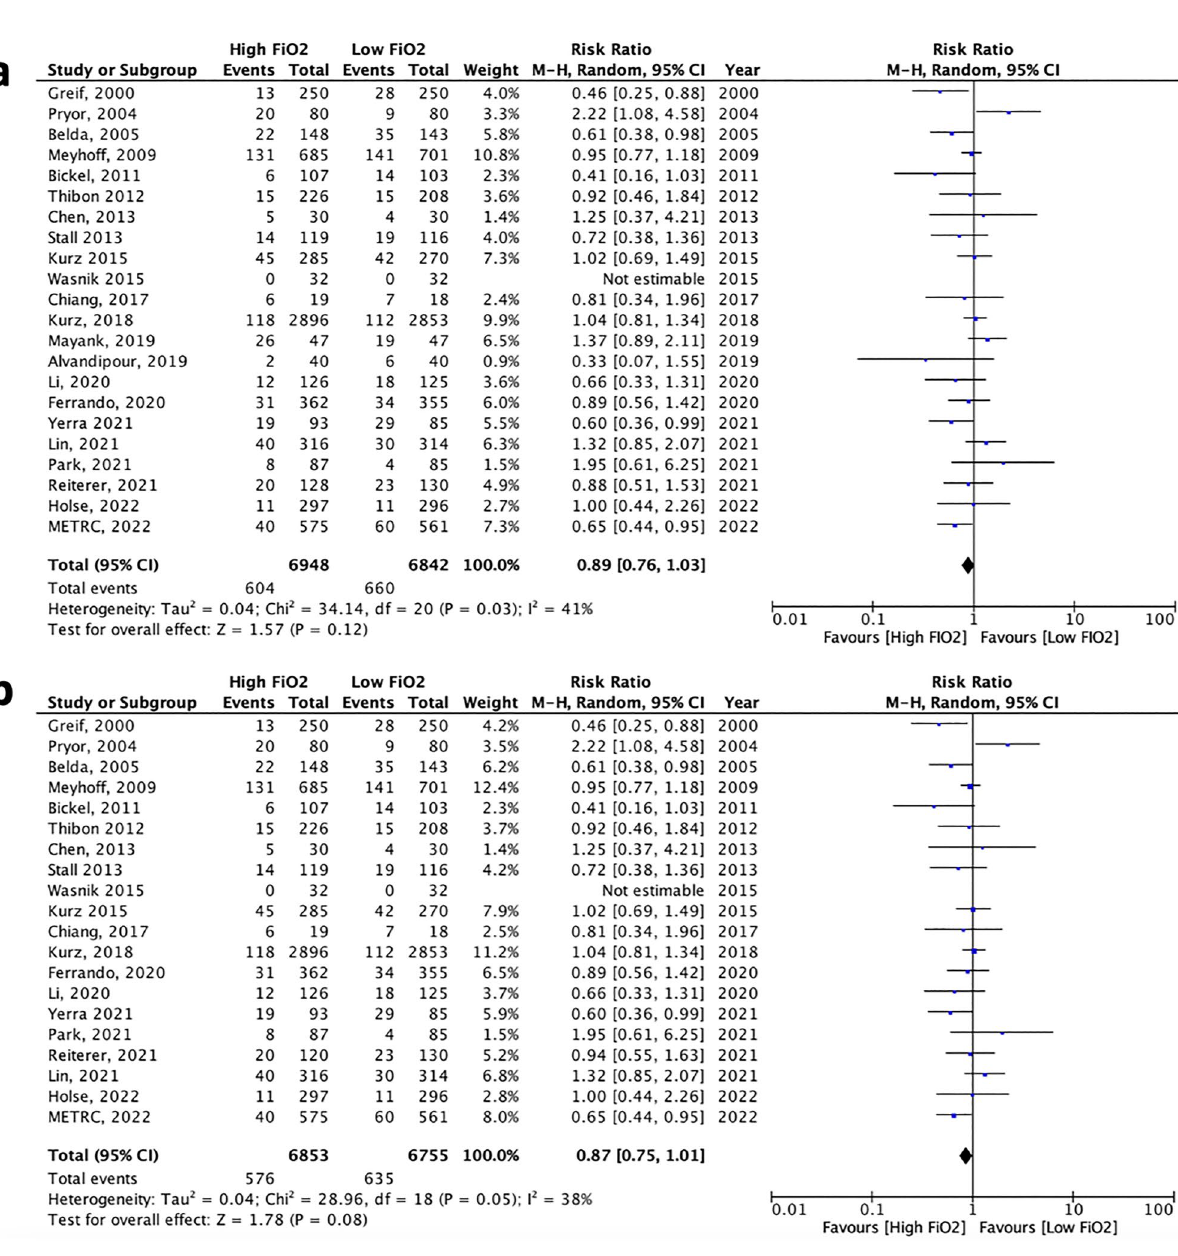
Figure 4. Sensitivity analysis of high versus low intraoperative FiO 2 on the incidence of SSI in patients operated under general anesthesia restricted to the 22 studies that used the same second gas in both the high and low FiO 2 group ( a ); and to the 20 studies that did not use nitrous oxide as second gas, neither in the high nor low FiO 2 groups ( b